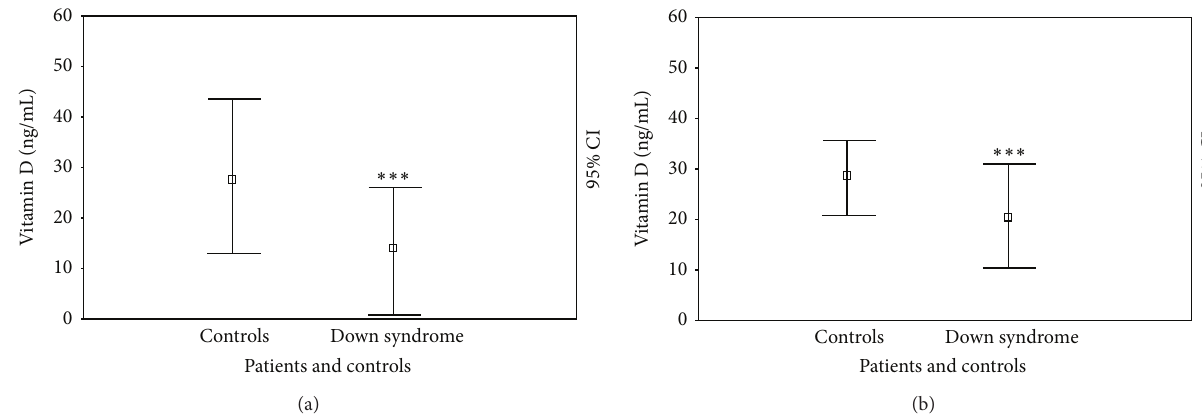
Figure 1: 25(OH)D levels (ng/mL) at cross-sectional (a) and longitudinal (b) evaluation in patients with Down syndrome and controls. ∗ 𝑃 < 0.05 ; ∗∗ 𝑃 < 0.005 ; ∗∗∗ 𝑃 < 0.001 .